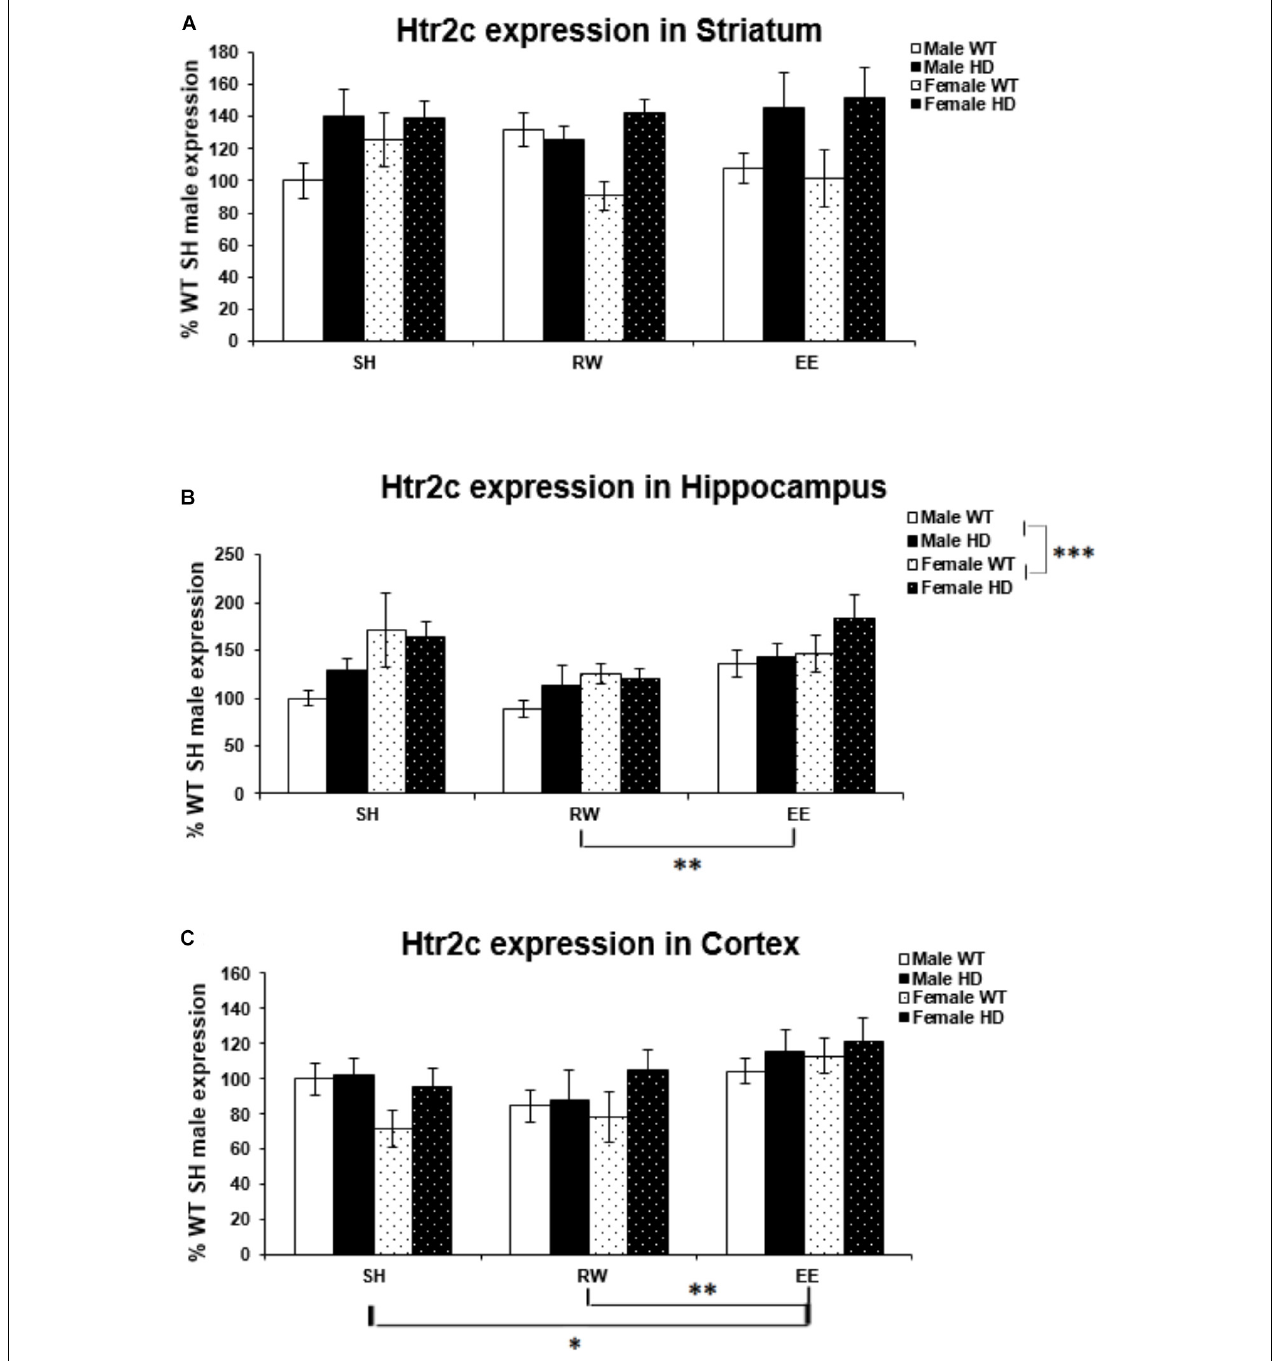
FIGURE 5 | Effects of genotype, environment and sex on Htr2c mRNA levels in 8-week-old WT and HD mice. (A) In Striatum, Htr2c expression was increased significantly in 8-week-old HD mice ( p < 0.001). Housing environment had no effect on Htr2c expression ( p = 0.912). (B) In Hippocampus, Genotype did not significantly affect Htr2c expression in 8-week-old HD mice ( p = 0.149). Housing environment had a significant effect on Htr2c expression ( p = 0.004). Post hoc testing showed that wheel running mice had significantly less Htr2c mRNA than mice exposed to EE ( p = 0.003), and showed a trend toward less Htr2c mRNA than SH mice ( p = 0.054). Male mice demonstrated significantly less Htr2c mRNA than female mice ( p = 0.001). (C) In Cortex, HD mice demonstrated no change in levels of Htr2c mRNA compared to WT mice ( p = 0.059). Housing environment had a significant effect on Htr2c expression ( p = 0.006). Post hoc testing showed that environmental enrichment ( p = 0.040), but not wheel running ( p = 0.846), significantly increased levels of Htr2c mRNA. n = 4–6 per group. Results are represented as mean ± SEM. Pairwise comparisons were conducted using Bonferonni’s adjustment for multiple comparisons: ∗ p < 0.05; ∗∗ p ≤ 0.01; ∗∗∗ p ≤